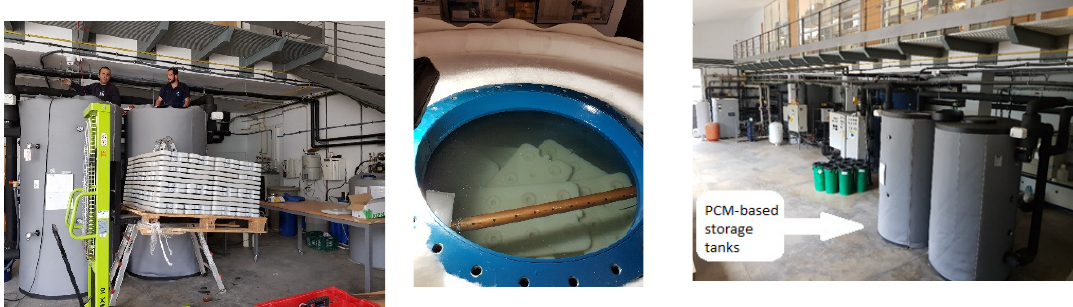
Figure 13. The SCH system with two newly installed PCM-based storage tanks.